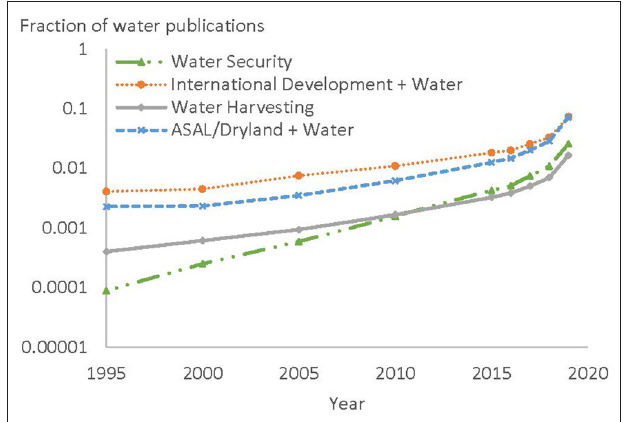
FIGURE 1 | Prevalence of dryland water harvesting topics in the full text of published literature as a fraction of all published literature on the topic of water in a given year. Source: Google Scholar, Date retrieved: 27 Dec